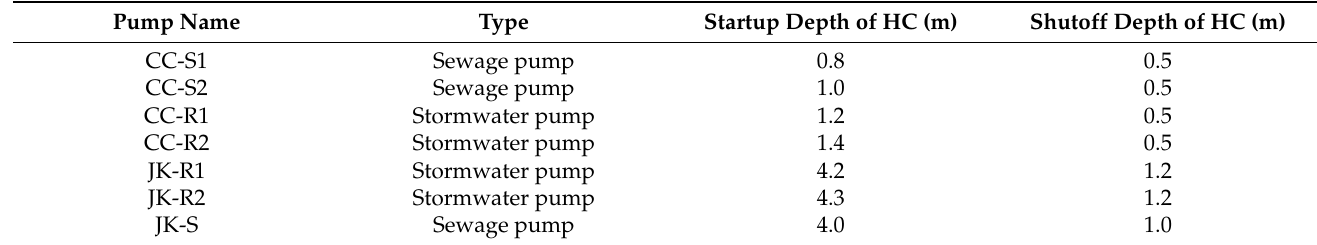
Figure 1. The SWMM model of the case study. The CC pump station has two sewage pumps (CC- S1, 2), two storm pumps (CC-R1, 2), and one storage tank (CC-storage). The JK pump station has one sewage pump (JK-S), two storm pumps (JK-R1, 2), and one storage tank JK-storage. The nodes in the upstream and downstream are used in the state design in Section 2.2. Table 1. Rule-based heuristic control (HC) system in the case study.